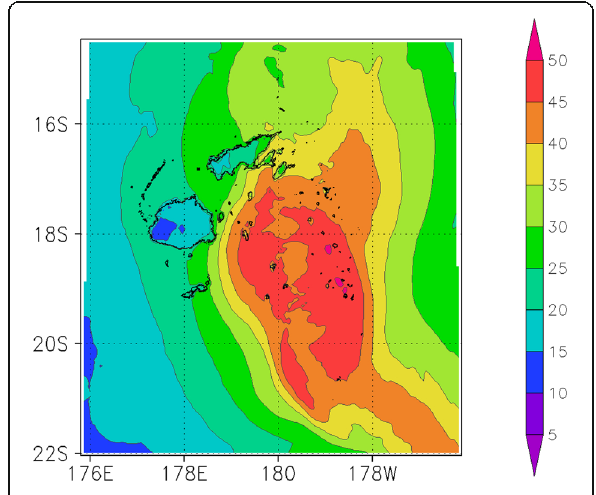
Fig. 7 Spatial distribution of the ensemble mean maximum wind speed in the CTL. The unit of the color bar is m/s